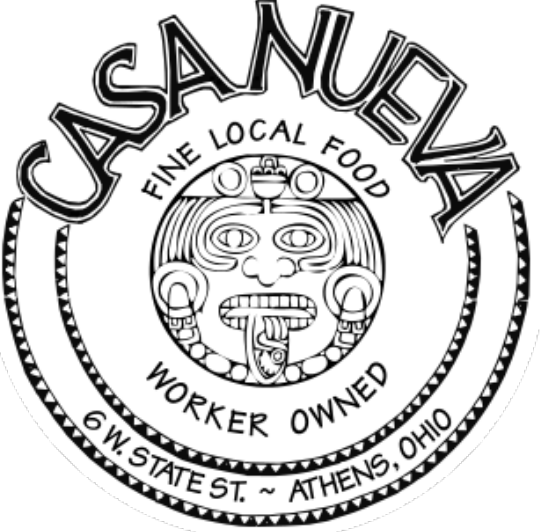
Figure 2. Logo of Casa Nueva restaurant. Source: (Casa Nueva n.d.a).